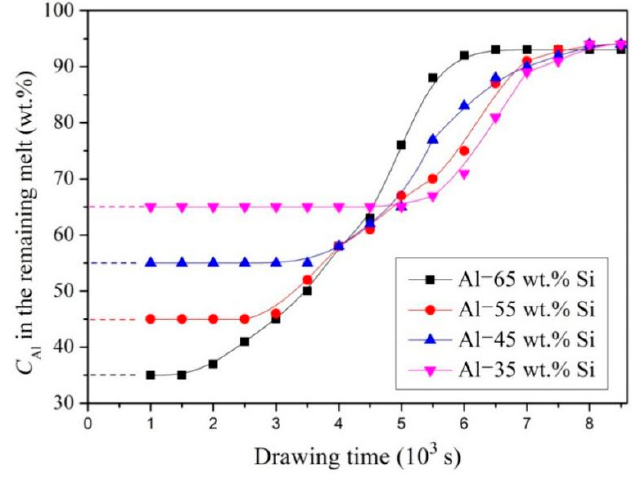
Figure 10. Variation of Al concentration in the remaining melts with the drawing time.